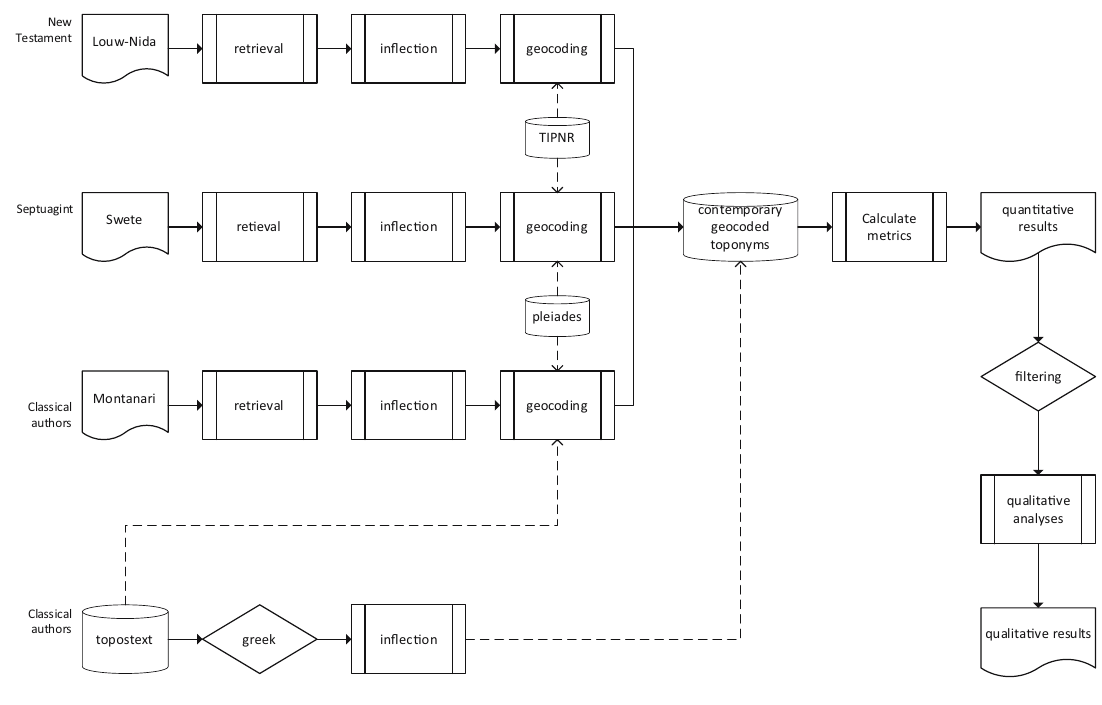
Figure 1: Method and